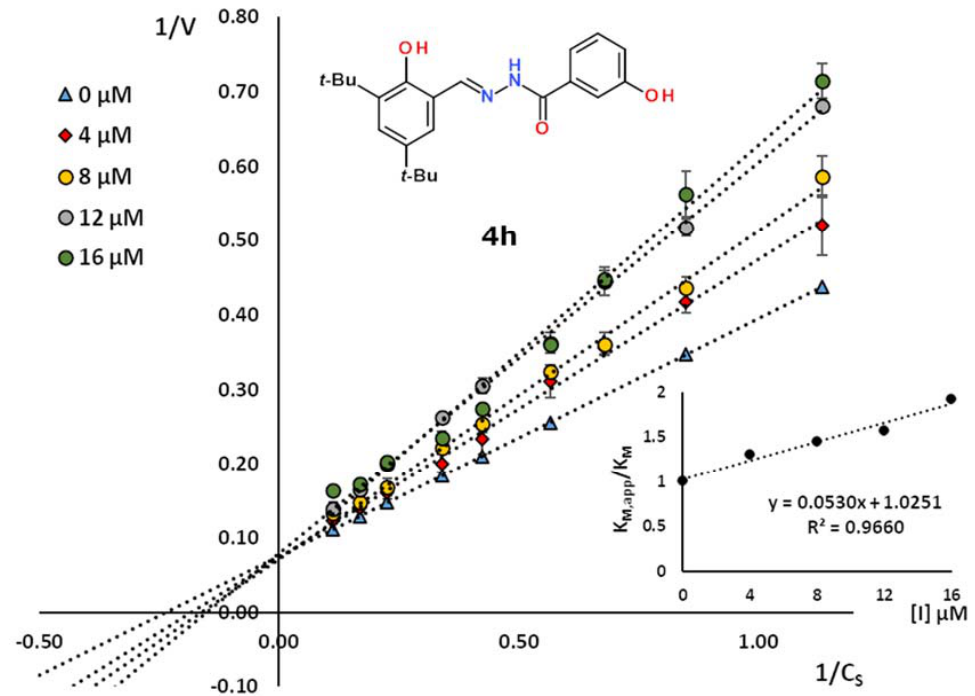
Figure 5. The Lineweaver–Burk plots (1/V [min µ M − 1 ] = f(1/C S ) [ µ M − 1 ]) for 4h performed for the inhibitor concentration up to 16 µ M. The additional graphs show the linear dependence of K M,app / K M = f(I) concerning the competitive mechanism.